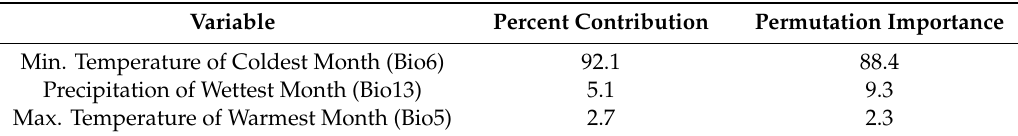
Table 1. Model 1a covariates included in the species distribution model (SDM) of Ae. aegypti , using all occurrence records of Ae. aegypti distribution in the United States, in order of highest to lowest permutation importance.